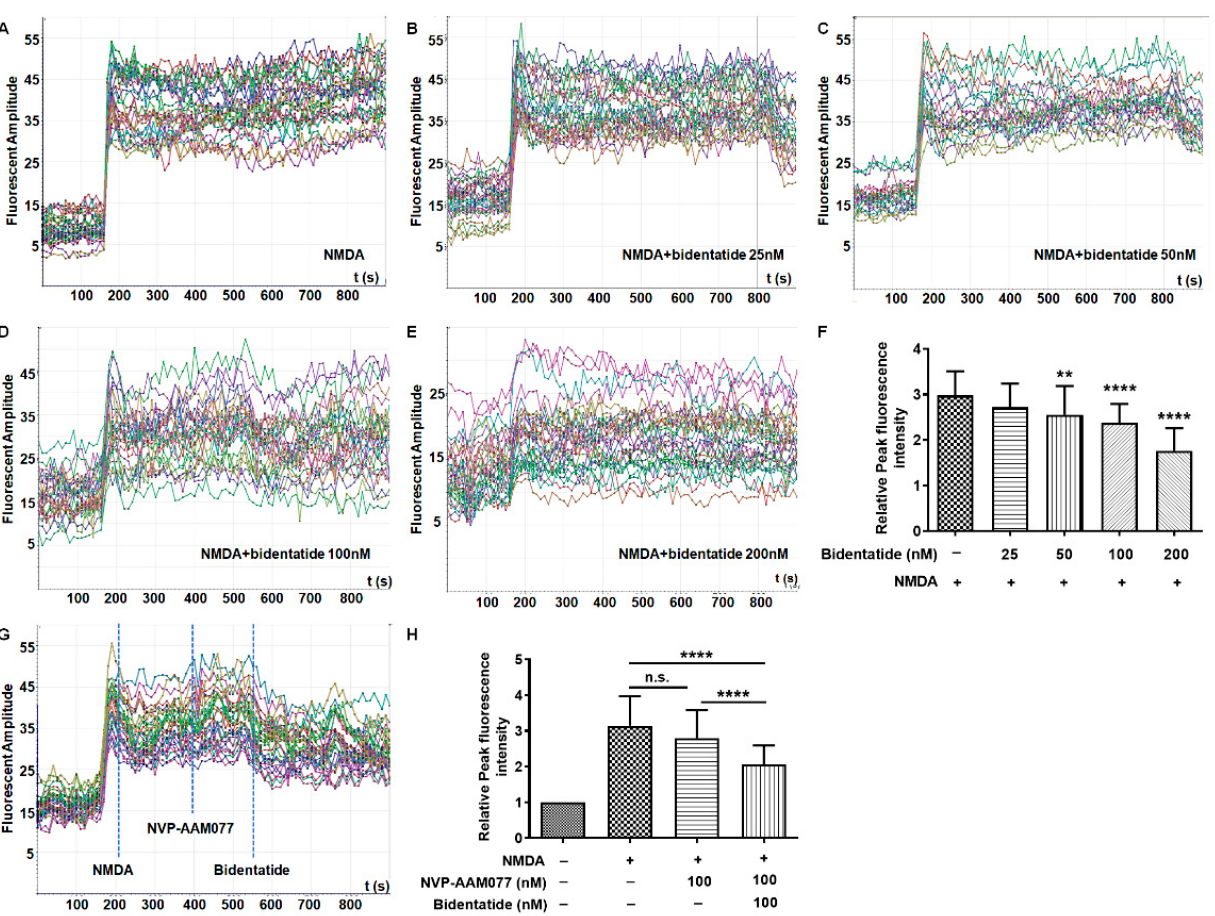
Figure 2. Bidentatide effects on NMDA-induced Ca 2+ overload in cultured hippocampal neurons: ( A – E ) dynamic changes of intracellular Ca 2+ levels in primary cultured hippocampal neurons upon pretreatment with different concentrations of bidentatide and exposure to NMDA (100 µ M); ( F ) bar graph showing the relative fluorescence intensity of NMDA-induced Ca 2+ in primary cultured hippocampal neurons; **** p < 0.0001 and ** p < 0.01 versus exposure to NMDA alone; ( G ) dynamic changes of intracellular Ca 2+ levels after the addition of 100 µ M NMDA, 100 nM NVP-AMM077, and 100 nM bidentatide; the dotted blue line represents the peak of fluorescence intensity; ( H ) bar graph showing the relative fluorescence intensity of NMDA-induced Ca 2+ in primary cultured hippocampal neurons; **** p < 0.0001; n.s. (no significance).